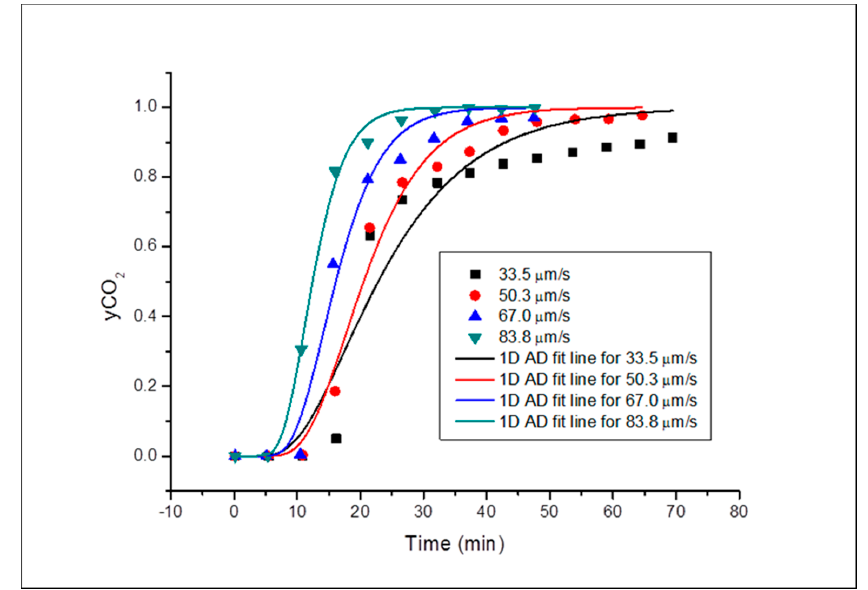
Figure 3. Concentration profile for Grey Berea in horizontal orientation.